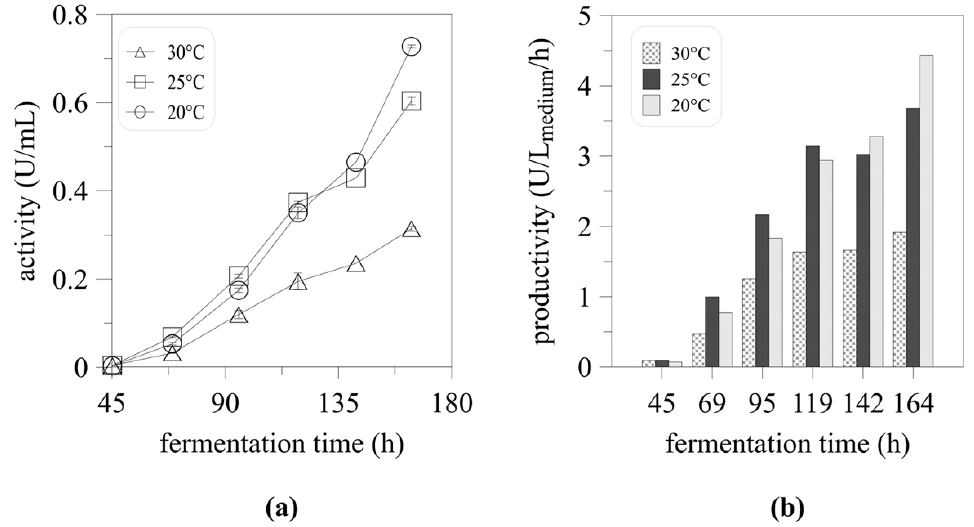
Figure 3. The effect of decreased induction temperature on myrosinase production in mini fermenters. Increase in myrosinase activity ( a ) and specific productivity ( b ) at decreased induction temperature in high cell density cultivation of Pichia pastoris KM71H (Mut S ) in mini fermenters.